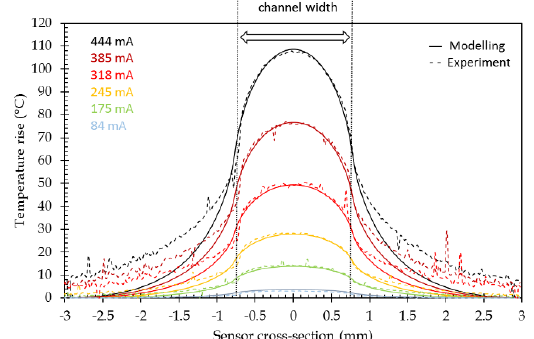
Figure 15. Comparison between the modeled (- - -) and experimental ( ___ ) cross-sectional tempera- ture rise.